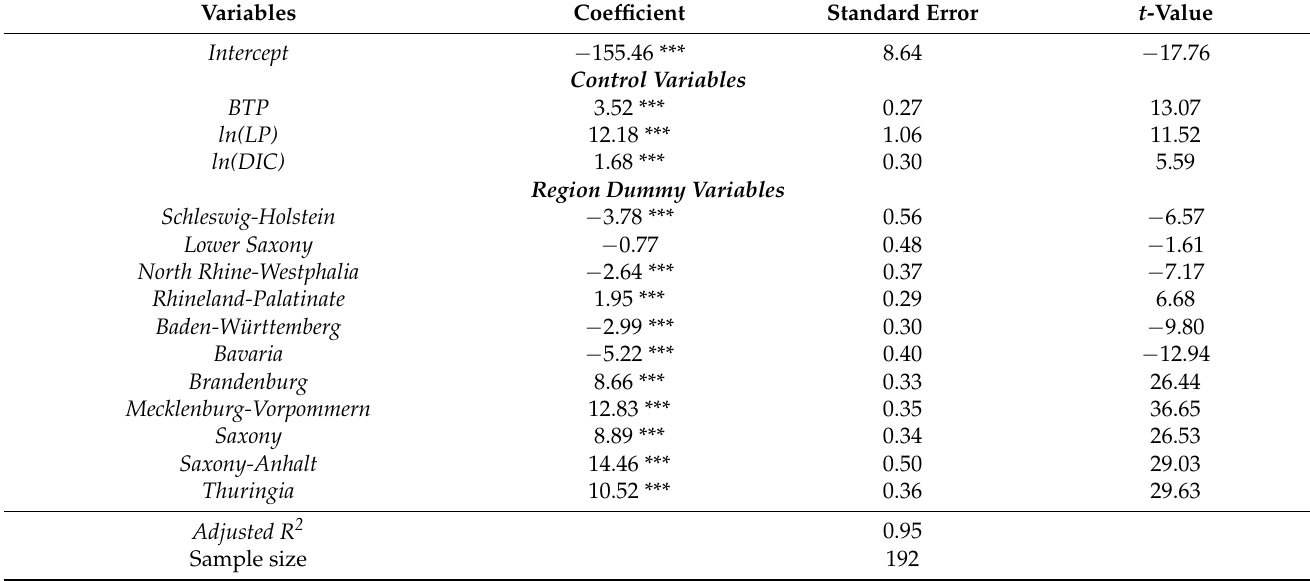
Table 6. Regression results.